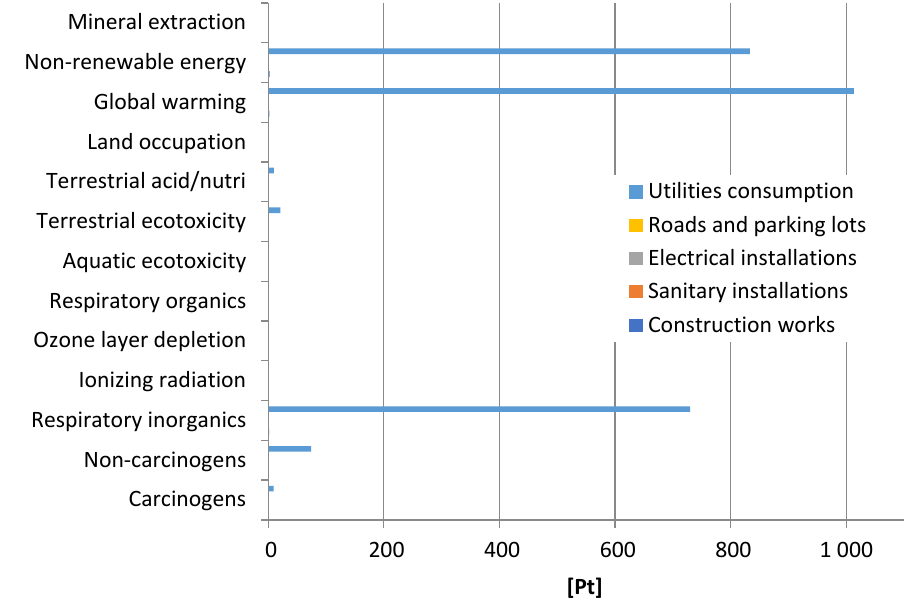
Figure 12. Results of grouping and weighing the environmental consequences occurring at the stage of operation of the research object by thirteen impact categories and groups of installations.